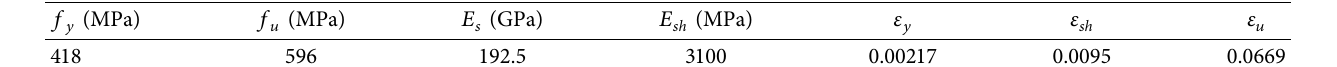
Table 2: Mechanical properties of the steel bar [1].